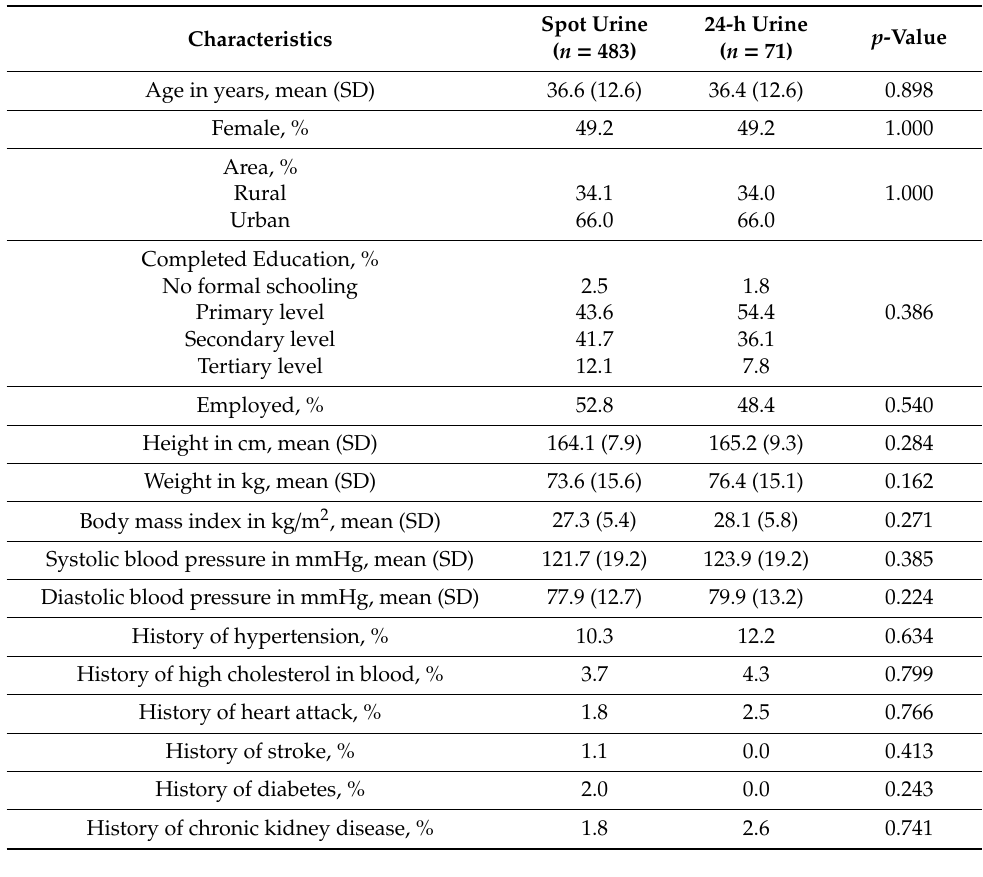
Table A1. Comparison of characteristics of subjects with spot vs. 24-h urine samples.